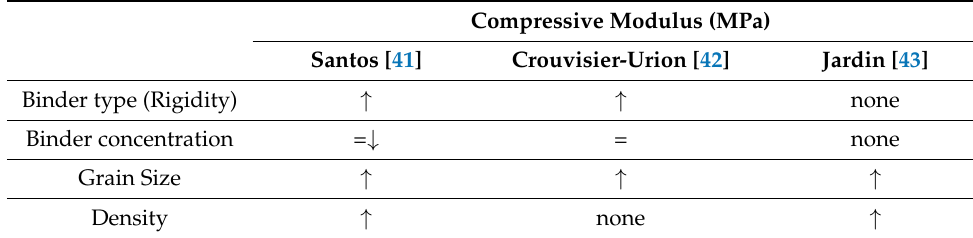
Table 5. Effect of an increase in the design parameters under consideration on the compressive stiffness of agglomerated cork.